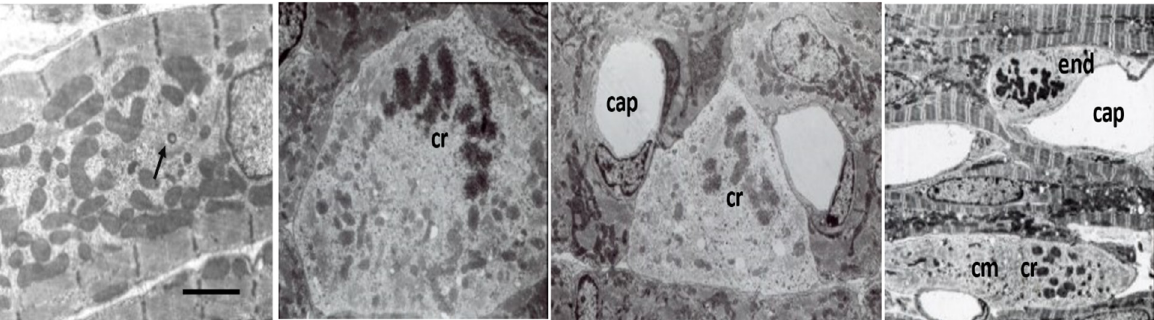
Figure 4. Electron micrographs of P3-P8 rat cardiomyocytes (cm). Left panel, subsarcolemmal fibrils, variable-sized mitochondria, and centrosome (arrow). Bar = 2 µm. Panels with mitoses with clumped chromatin (cr), dispersed myofibrils small mitochondria, and pale cytoplasm. Capillaries (cap) are dilated due to perfusion fixation. Endothelial cell mitosis (end).